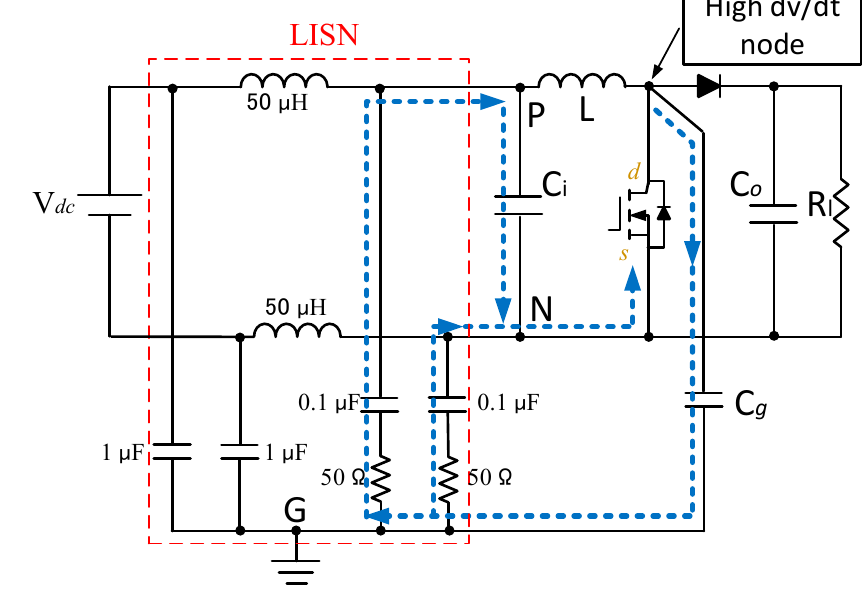
Figure 1. Configuration of the conventional boost circuit (CBC) and LISN setup.